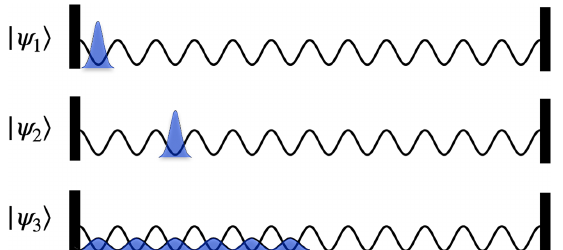
FIG. 6. Three initial states for a single-particle system: | ψ 1 (cid:4) in Eq. (77), | ψ 2 (cid:4) in Eq. (78), and | ψ 3 (cid:4) in Eq. (79) with L = 12. The state | ψ 3 (cid:4) has a larger expectation value of the transition Hamiltonian than | ψ 1 (cid:4) and | ψ 2 (cid:4) .